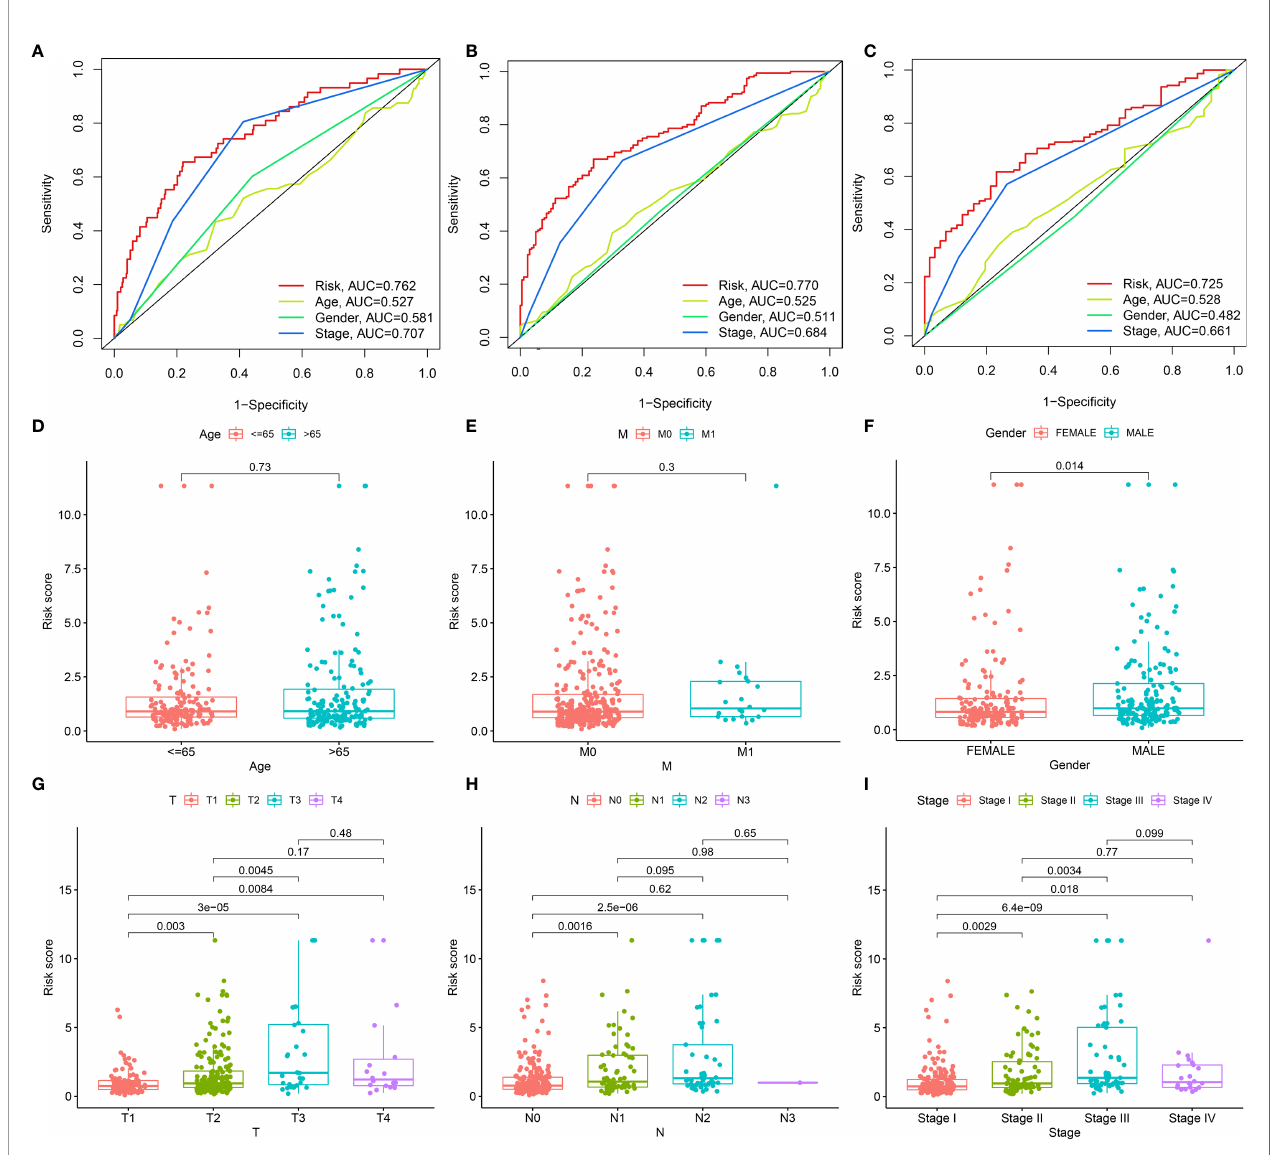
FIGURE 3 | Associations of the prognostic model with clinicopathological characteristics of LUAD. (A – C) Comparisons of AUC at 1-, 3-, and 5-year survival estimated by risk score and clinicopathological characteristics through ROC analysis. (D – I) Box plots showing the distribution of risk scores in distinct clinicopathological characteristics, containing (D) age ( ≤ 65 vs. > 65), (E) M stage (M0 vs. M1), (F) gender (female vs. male), (G) T stage (T1 vs. T2 vs. T3 vs. T4), (H) N stage (N0 vs. N1 vs. N2 vs. N3) and (I) stage (stage I vs. stage II vs. stage III vs. stage